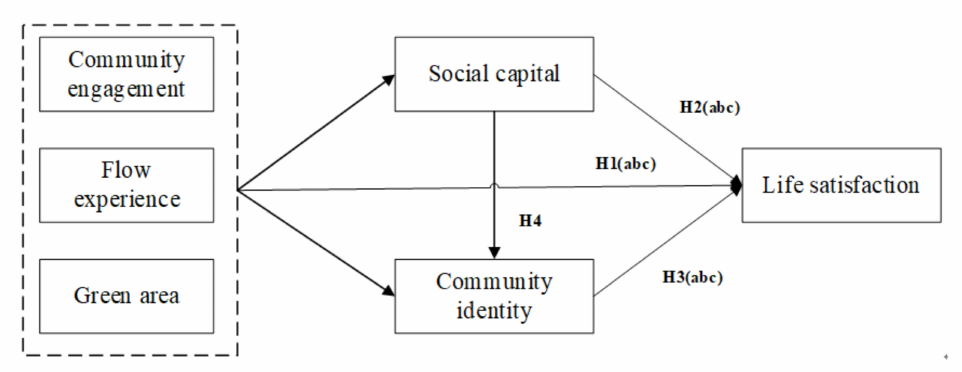
Figure 4. The conceptual